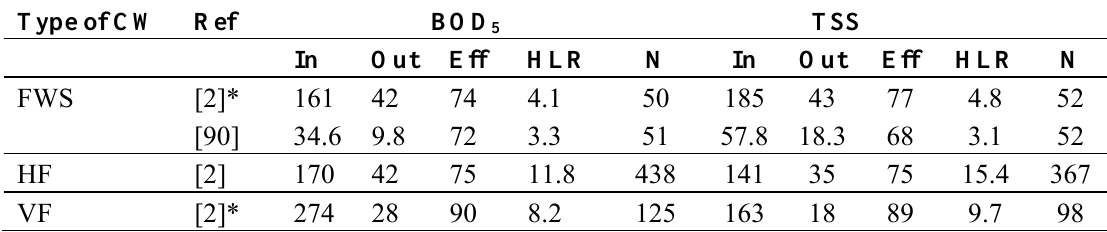
Table 4. Treatment efficiency (Eff, in %) of various types of constructed wetlands (CWs) for organics and suspended solids. Inflow (In) and outflow (Out) concentrations in mg/L. HLR = hydraulic loading rate (cm/d). N = number of CWs. * updated.